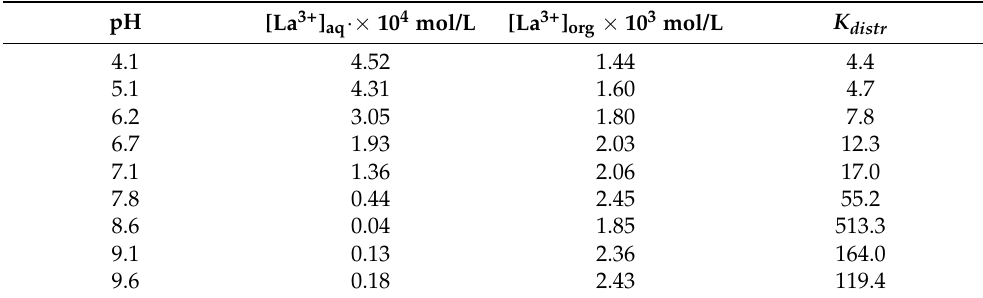
Table 1. The results of the experimental study of lanthanum (III) cations recovery to froth pulp in nitrate-chloride medium at the NaCl concentration of 0.01 M.